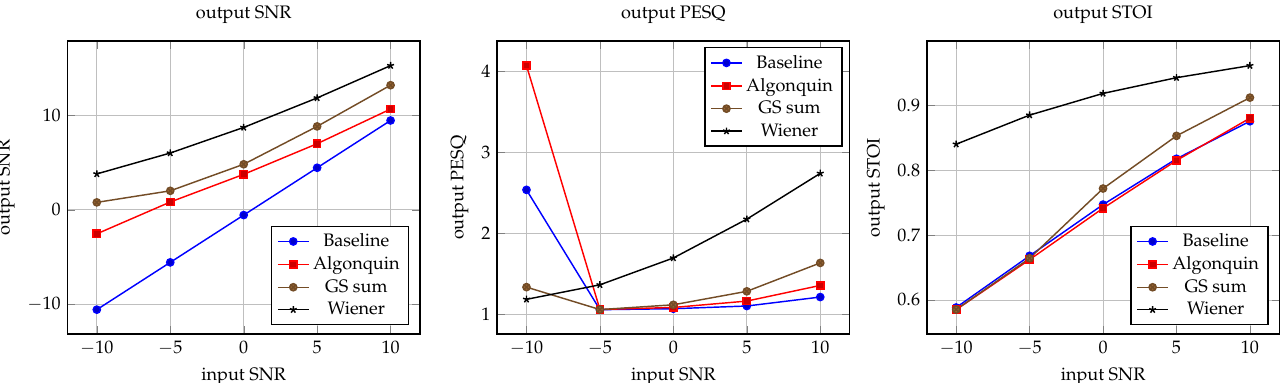
Figure 10. Overview of the performance metrics for the second experiment as described in Section 3.1. For a varying input SNR, the output SNR ( left ), the PESQ ( middle ) and the STOI ( right ) are evaluated for both models from Section 2.2 for 2 noise mixture components. For comparison the baseline performance of the noisy signal has been included, in addition to the results obtained by the Wiener filter. It should be noted that the input SNR refers to the signal before entering the frequency-warped filter, causing the offset in the left plot.